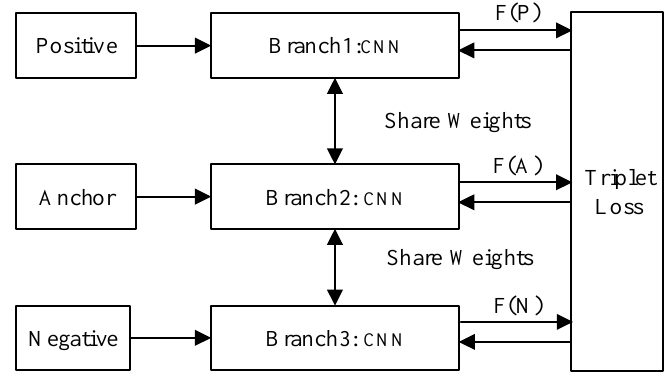
Figure 2. The structure of the triple network.